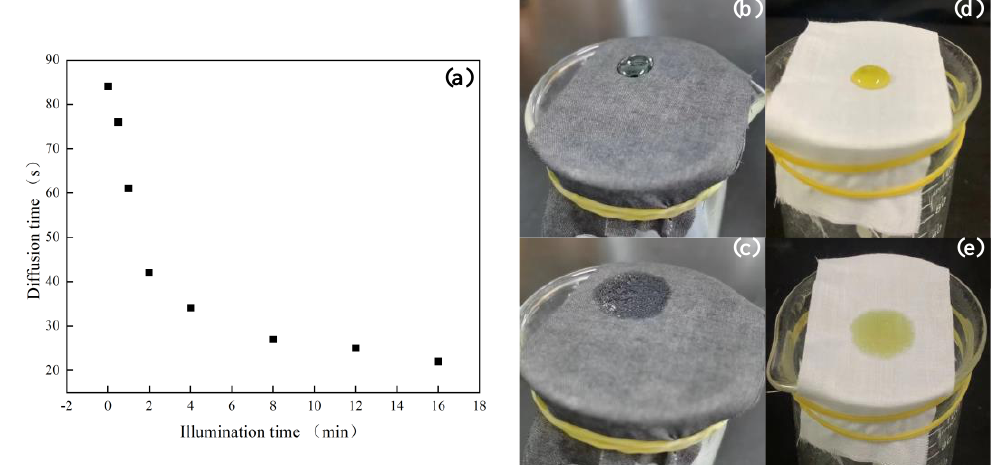
Figure 11. How quickly the CA-Fe-SH-PET fabric adsorbs diesel oil ( a ); state of diesel oil contacting the CA-Fe-SH-PET fabric ( b ); state of diesel oil completely adsorbed by the CA-Fe-SH-PET fabric ( c ); state of diesel oil contacting the PET fabric ( d ); state of diesel oil completely adsorbed by the PET fabric ( e ).